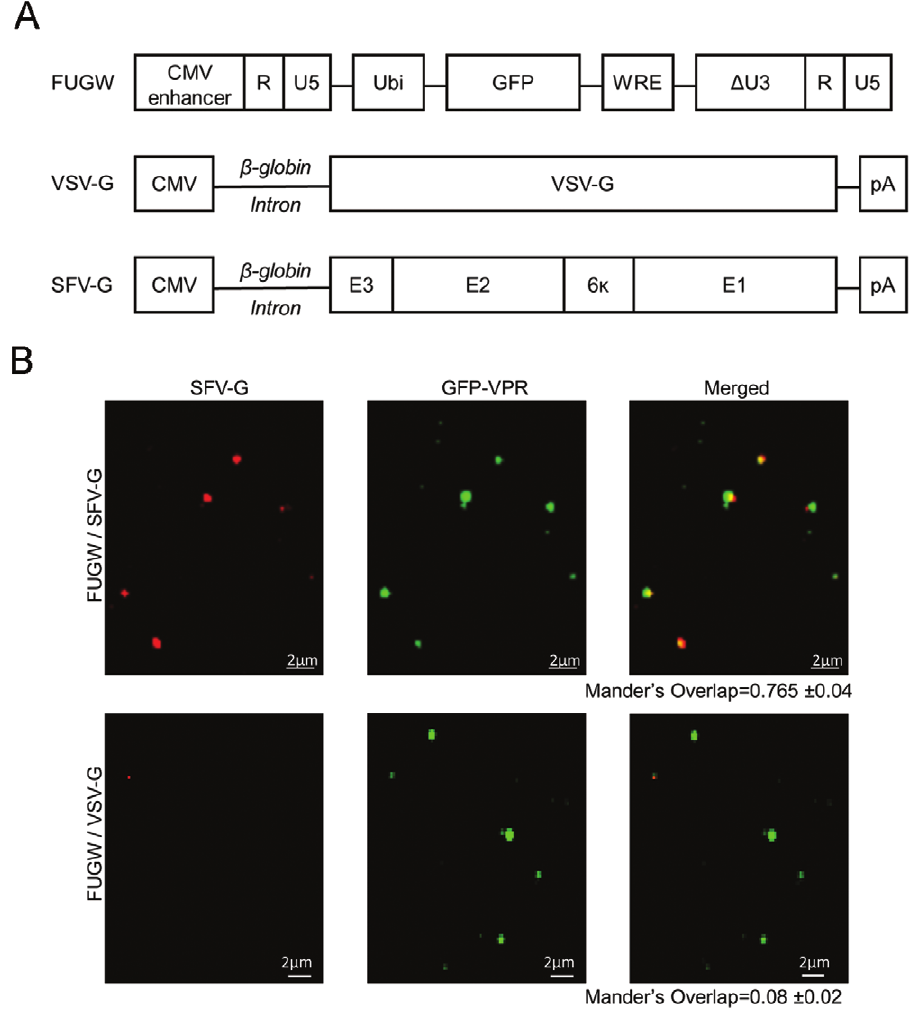
Figure 1. Virus-producing constructs used to make pseudotyped lentiviruses. (A) Schematic diagrams of constructs encoding the lentiviral backbone FUGW and envelope glycoproteins. Ubi: the human ubiquitin-C promoter; GFP: enhanced green fluorescence protein; WRE: the woodchuck hepatitis virus posttranscriptional regulatory element (WRE) to increase the level of transcription; D U3: deleted U3 region that results in the transcriptional activation of the integrated viral LTR promoter; pA: polyadenylation signal; E1, E2, 6k, E3: SFV-glycoprotein (E1 for fusion, E2 for receptor binding, 6k a linker, and E3 is a signal sequence). The VSV-G expressing plasmid contains the rabbit b -globin intron and poly(A) signal. (B) Viral supernatants harvested from virus-producing cells transiently transfected with GFP-vpr, SFV-G, or VSV-G, and other necessary packaging constructs, were coated to a poly-lysine containing coverslip by centrifugation. The resulting coverslips were then rinsed and immunostained with an anti-SFV-G antibody (red) to label the glycoproteins and imaged using a laser confocal